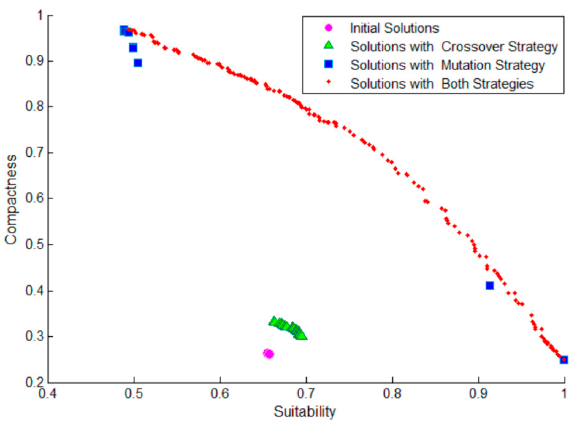
Figure 17. Comparison of different neighborhood search strategies.